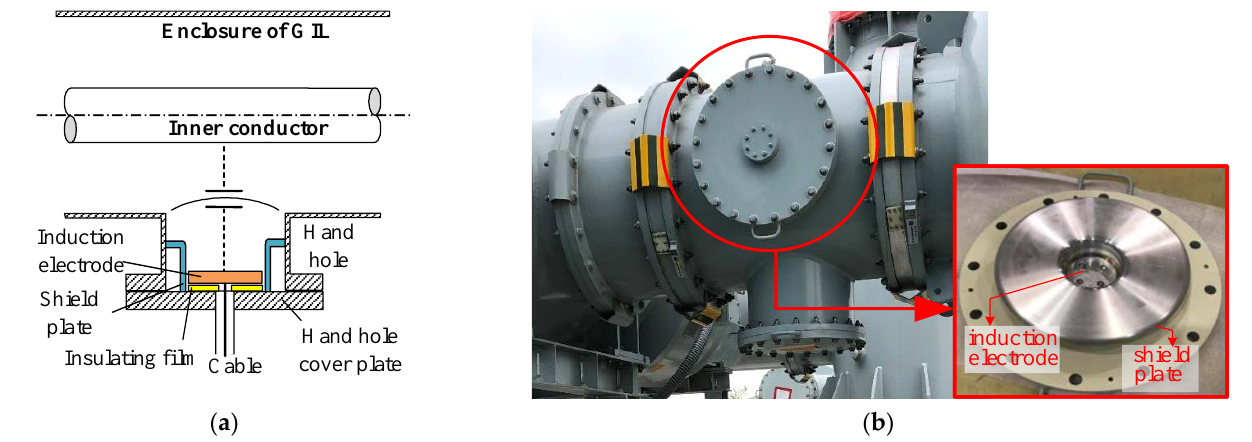
Figure 2. Ultra-wideband voltage sensor. ( a ) Schematic structure of the voltage sensor; ( b ) entity of voltage sensor and its installation position.